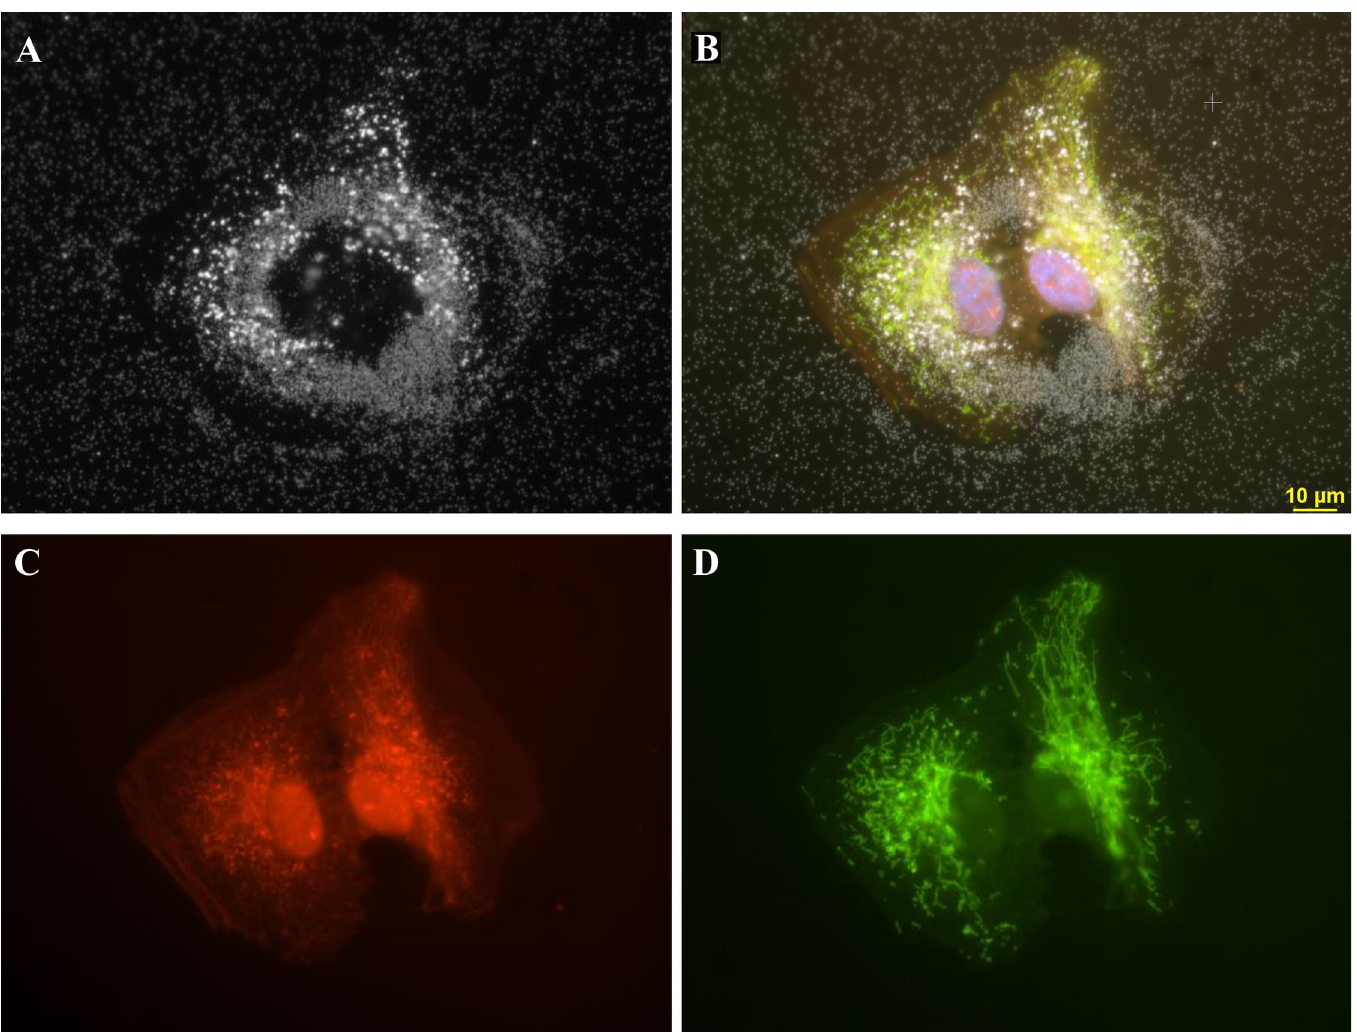
combined into a composite image (B). DAPI stained nuclei (blue) image was added to the composite. Panel C. Cell stained with CellMask Orange plasma membrane stain. Panel D. Cells transfected with Mito-GFP (green). Magnification